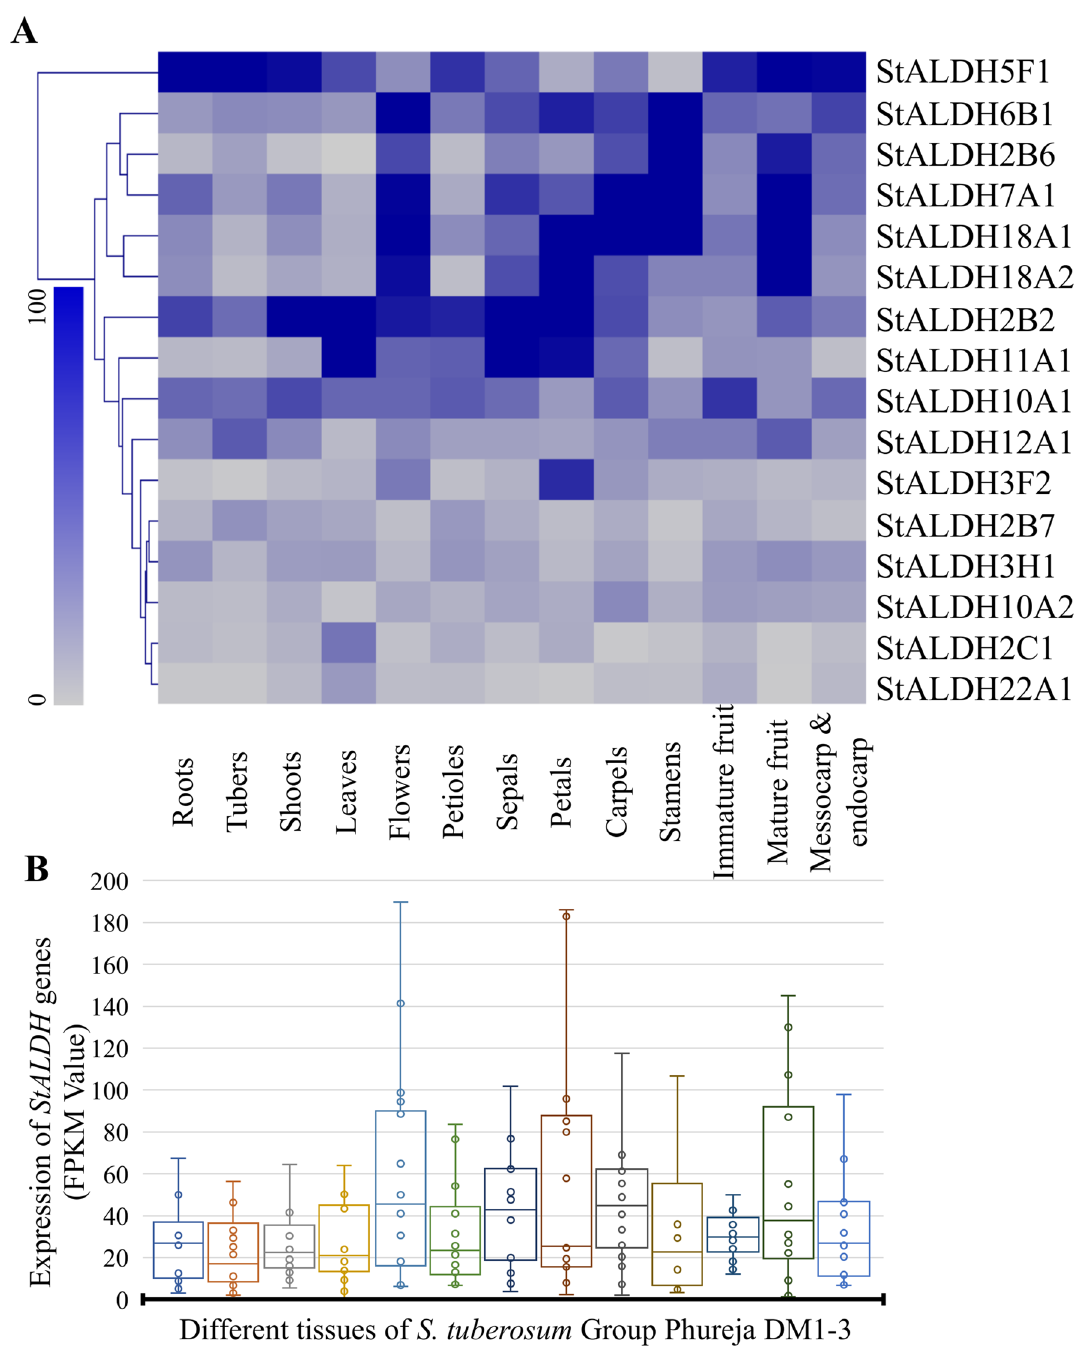
Figure 5. Expression profiles of StALDH s at different tissues. Transcript abundance of 16 StALDH genes in thirteen different tissues (roots, tubers, shoots, leaves, flowers, petioles, sepals, petals, carpels, stamens, immature fruits, mature fruit and inside of fruit) was analyzed. ( A ) The RNA-seq data was retrieved from Potato Genome Sequencing Consortium (PGSC). The Fragments Per Kilobase of transcript per Million mapped reads (FPKM) values were normalized and the heatmap was generated with a hierarchical clustering of Manhattan distance correlation using MeV 4.9 software (http:// mev. tm4. org/). The colour bar represents relative expression values, where the increase in the intensities of blue colour represents the level of expression. ( B ) The box and whisker scatter plot illustrate the FPKM value of each gene at each tissue. The tissue name in 4Acorrespondsd to the boxes in